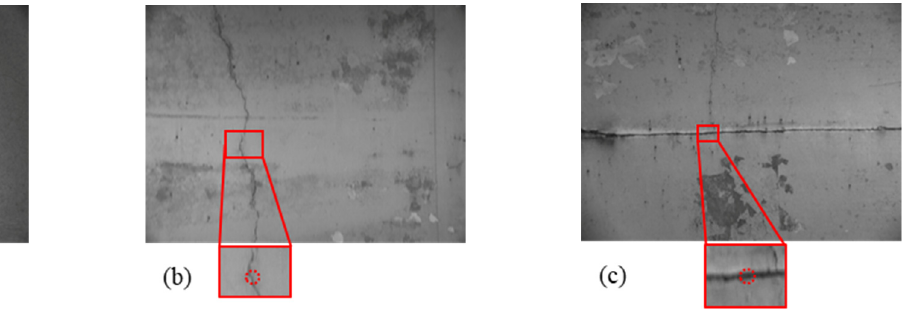
Figure 13. Images of tunnel lining cracks, ( a ) cracks picture with breakage, ( b ) cracks picture with seepage, ( c ) cracks picture with stains, ( d ) cracks picture with expansion joint.